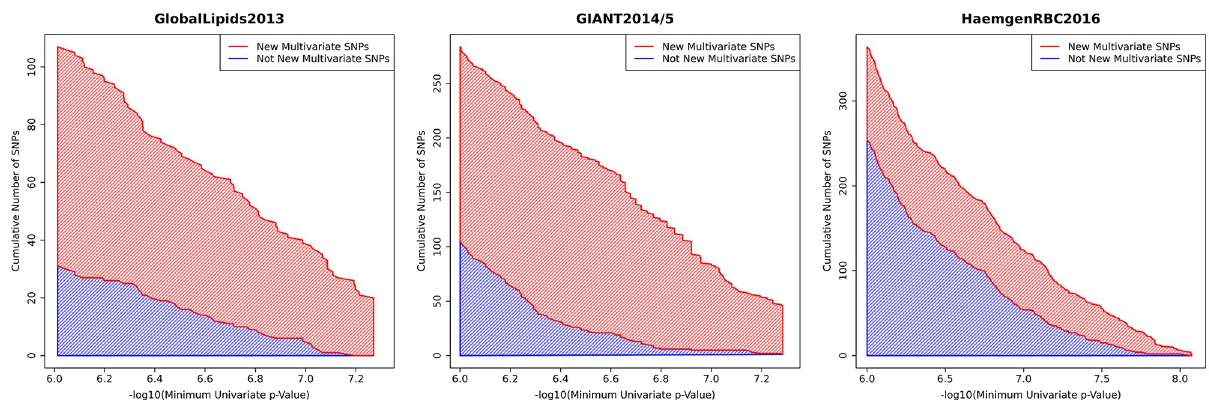
Fig 3. Comparison of new multivariate hits vs. relaxing univariate p -value threshold. For each data set the graph shows how many associations become significant as the univariate p -value threshold is relaxed (moving from right to left on the x -axis), and how many of these are declared as new multivariate hits in our analysis. In both cases results are pruned to avoid counting associations of SNPs in strong LD; see Methods for details. The appearance of appreciable blue areas indicates that the multivariate analysis is reordering the significance of SNPs compared with performing multiple univariate